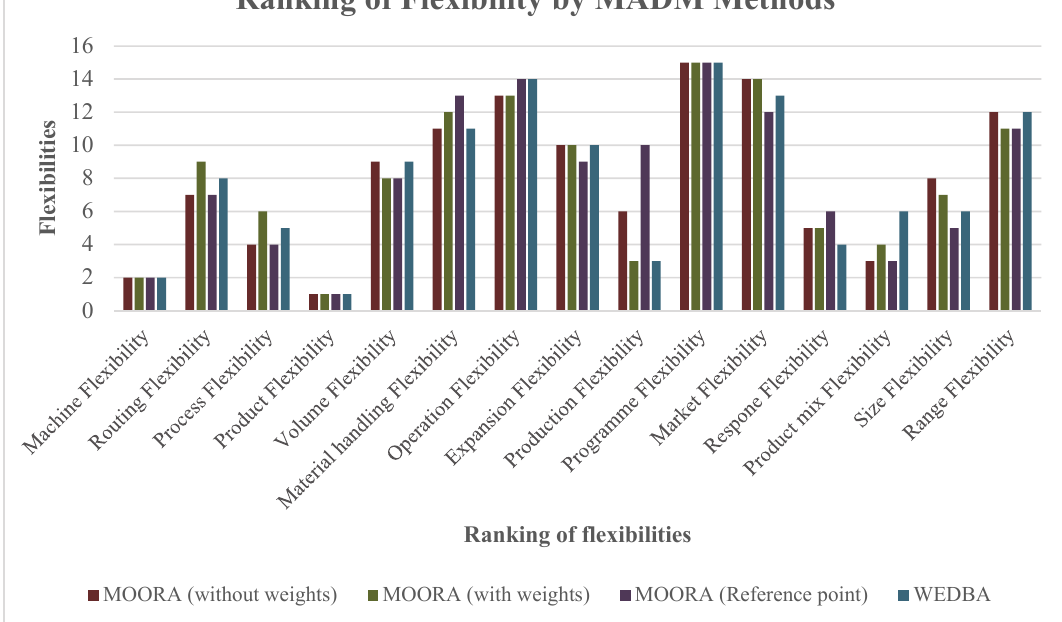
Fig. 5. Ranking of flexibility of FMS by MOORA and WEDBA